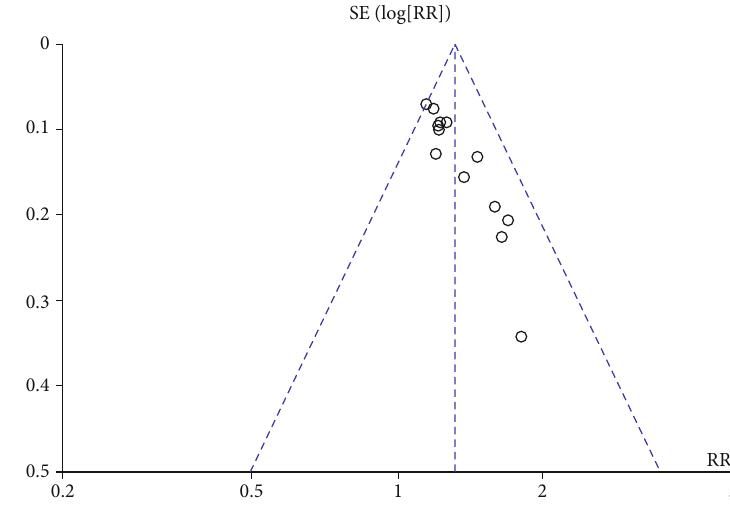
Figure 8: Funnel plot of acupuncture versus no acupuncture on e ffi cacy rate.